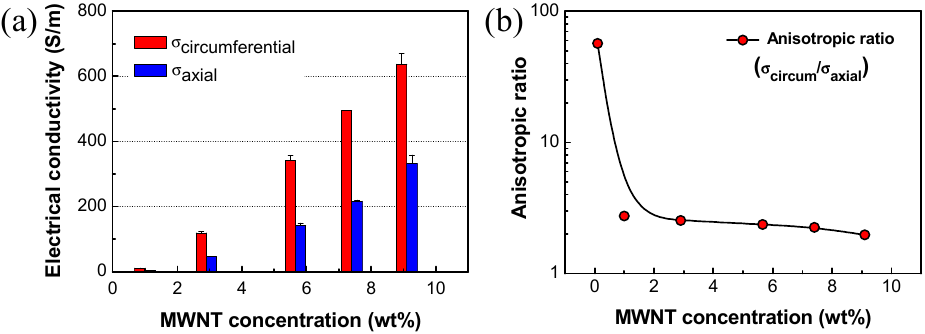
Figure 6. ( a ) Electrical conductivity of MWNT/PDMS composite. ( b ) Anisotropic ratio of electrical conductivity as a function of MWNT contents (axial: axial direction, circum: circumferential direction).